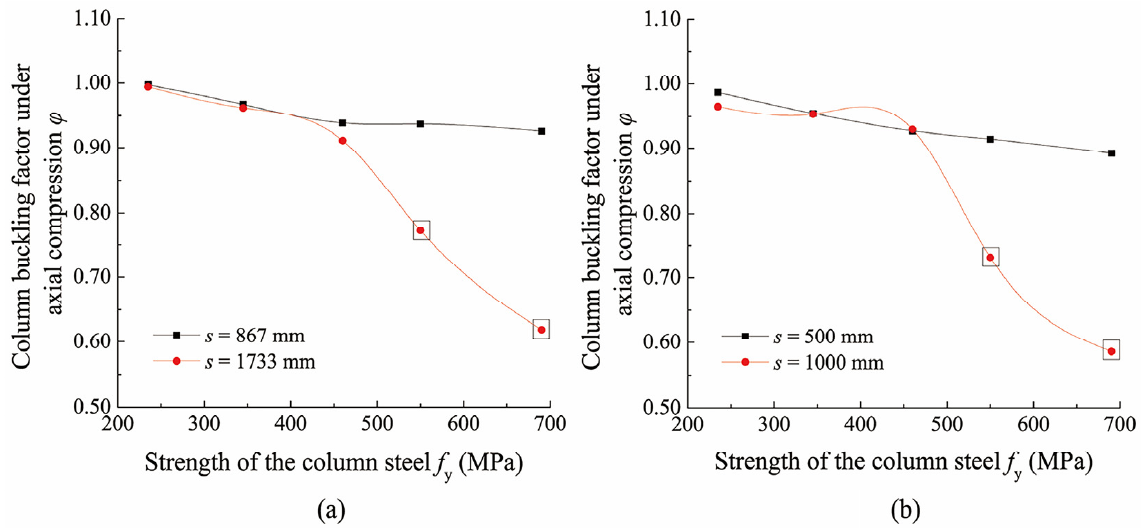
Figure 16. Relationship between column buckling factors and yield strengths of column steel for varying stiffener spacing: ( a ) Model M4- s , ( b ) Model M5- s . varying stiffener spacing: ( a ) Model M4- s , ( b ) Model M5- s